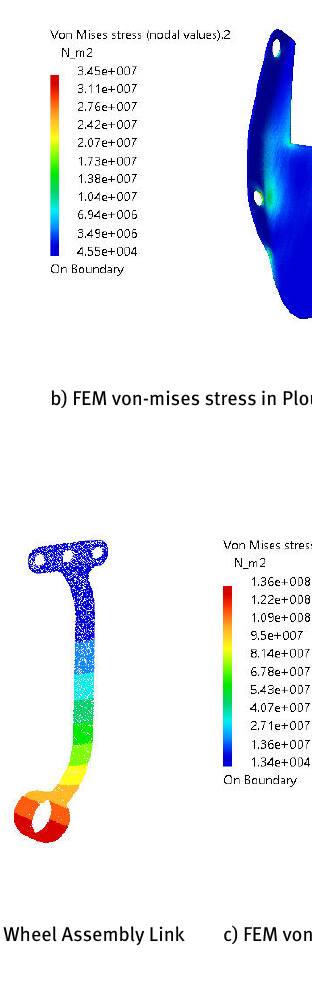
Figure 3: FEM Analysis in Wheel Assembly Link